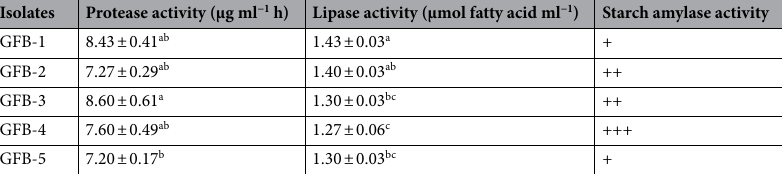
Table 2. The effects of the five gut probiotic bacteria on the digestive enzymes activity. Values are expressed as mean. Different letters on the rows indicate significant difference by LSD test ( P < 0.05); (n = 3); Inhibition zone > 3 = +++, > 2 = ++, > 1 = +.